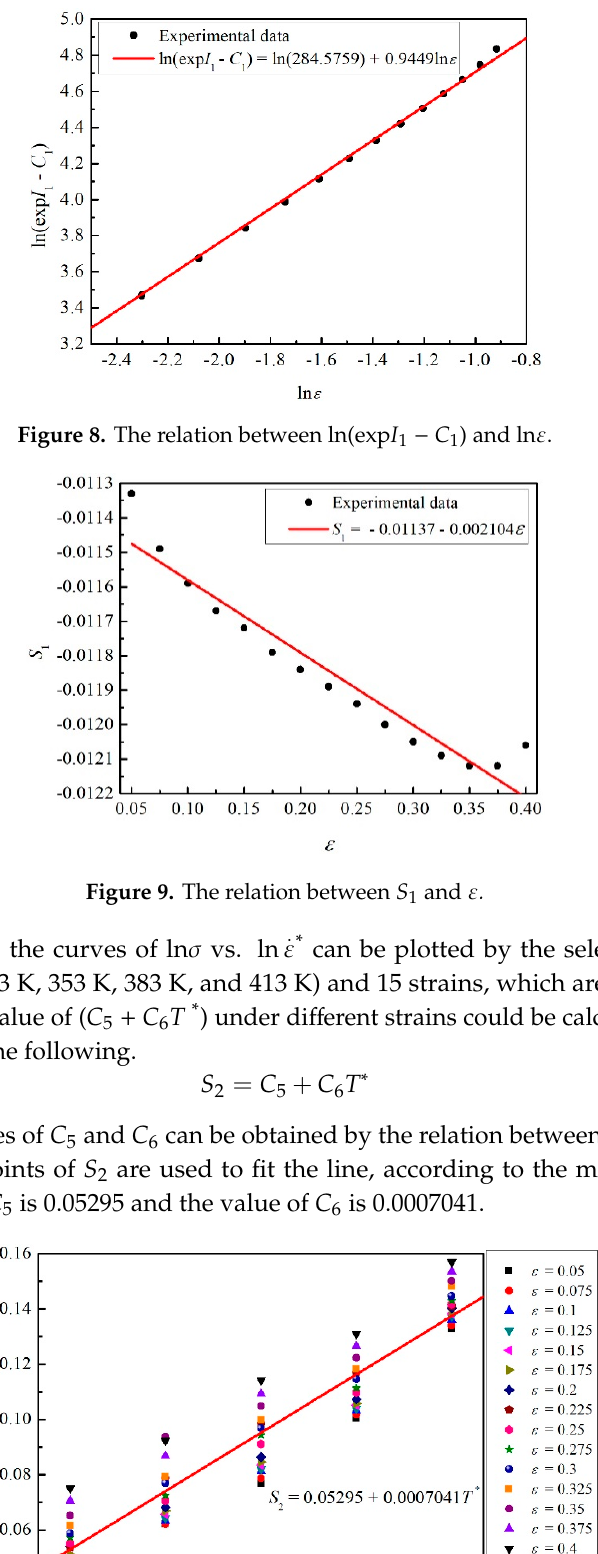
Figure 10. Scatter plot of S 2 vs. T * for different strains and the most suitable fitting line.